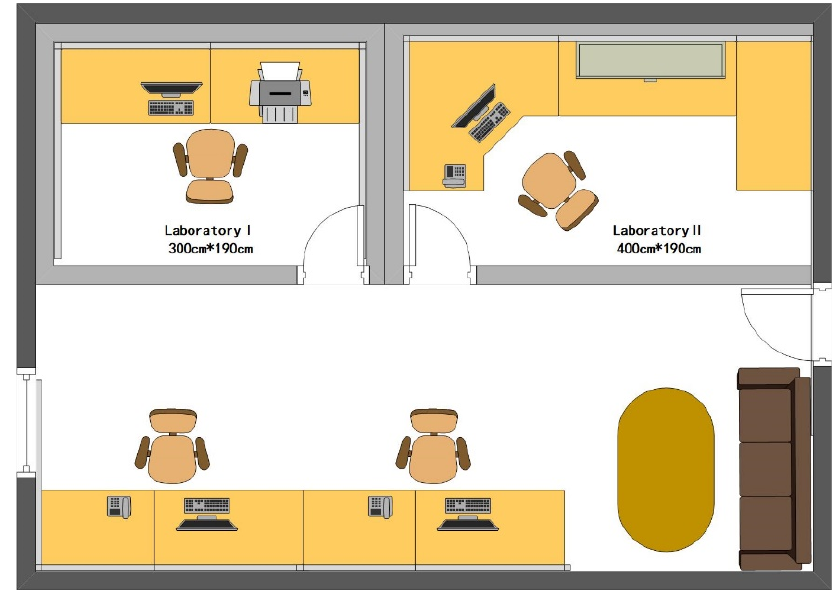
Figure 1. Detailed view of full-scale mock-up model